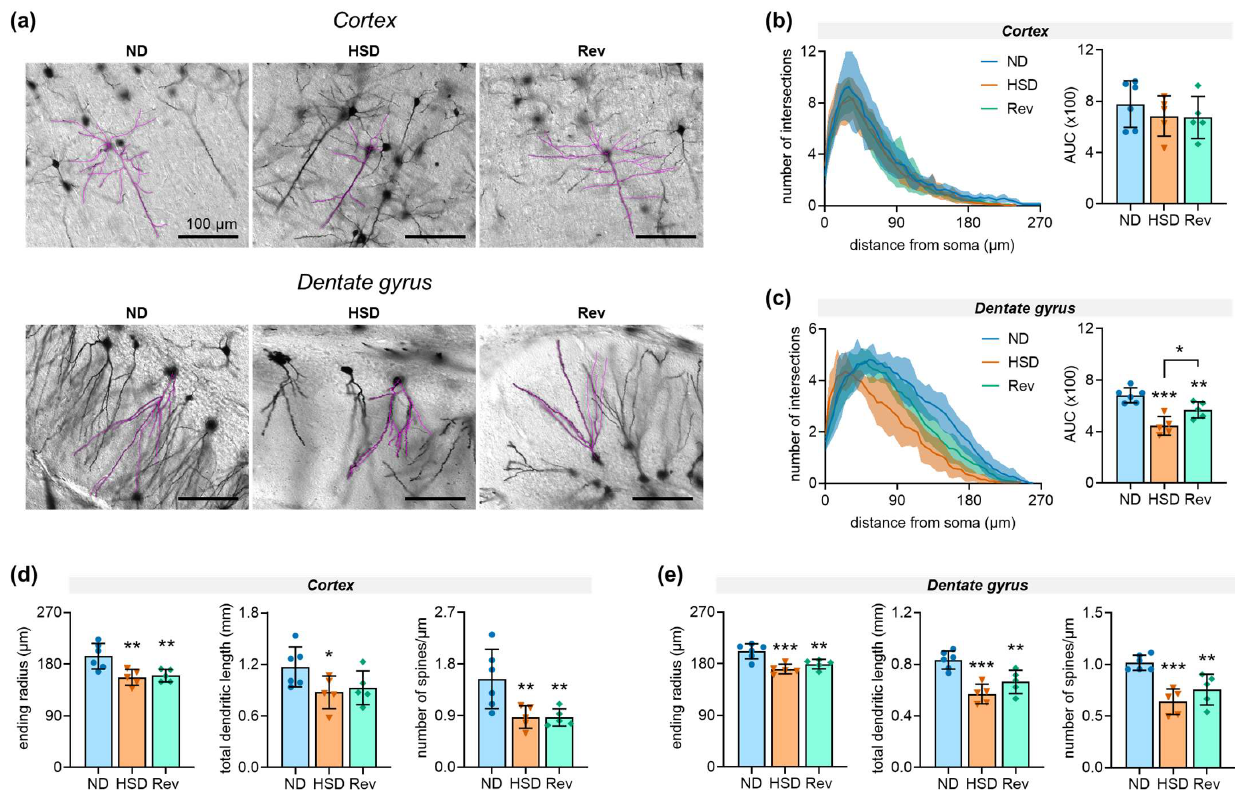
Figure 5. Neuronal morphology after 14 months feeding with normal diet (ND), high-salt diet (HSD), or HSD followed by diet reversal (Rev). ( a ) Representative micrographs of Golgi–Cox-stained pyramidal neurons in the cortex and granule cells in the dentate gyrus of the hippocampus. Dendritic morphologies in typical Sholl analyses are highlighted by the superimposed magenta traces. ( b , c ) Sholl analysis showing number of dendrite intersections (i.e., dendritic branching) vs . distance from neuronal soma. ( d , e ) Maximal dendritic length (i.e., ending radius), total dendritic length, and dendritic spine density (number of spines on third-order branch) for neurons in the cortex and dentate gyrus. Data are means ± SDs of n = 5–6. Symbols overlaid on bars represent independent measurements from each mouse. * p < 0.05, ** p < 0.01, *** p < 0.001 compared to ND by Fisher LSD tests after significant results were determined by one-way ANOVA. Bars over micrographs represent 100 µm.